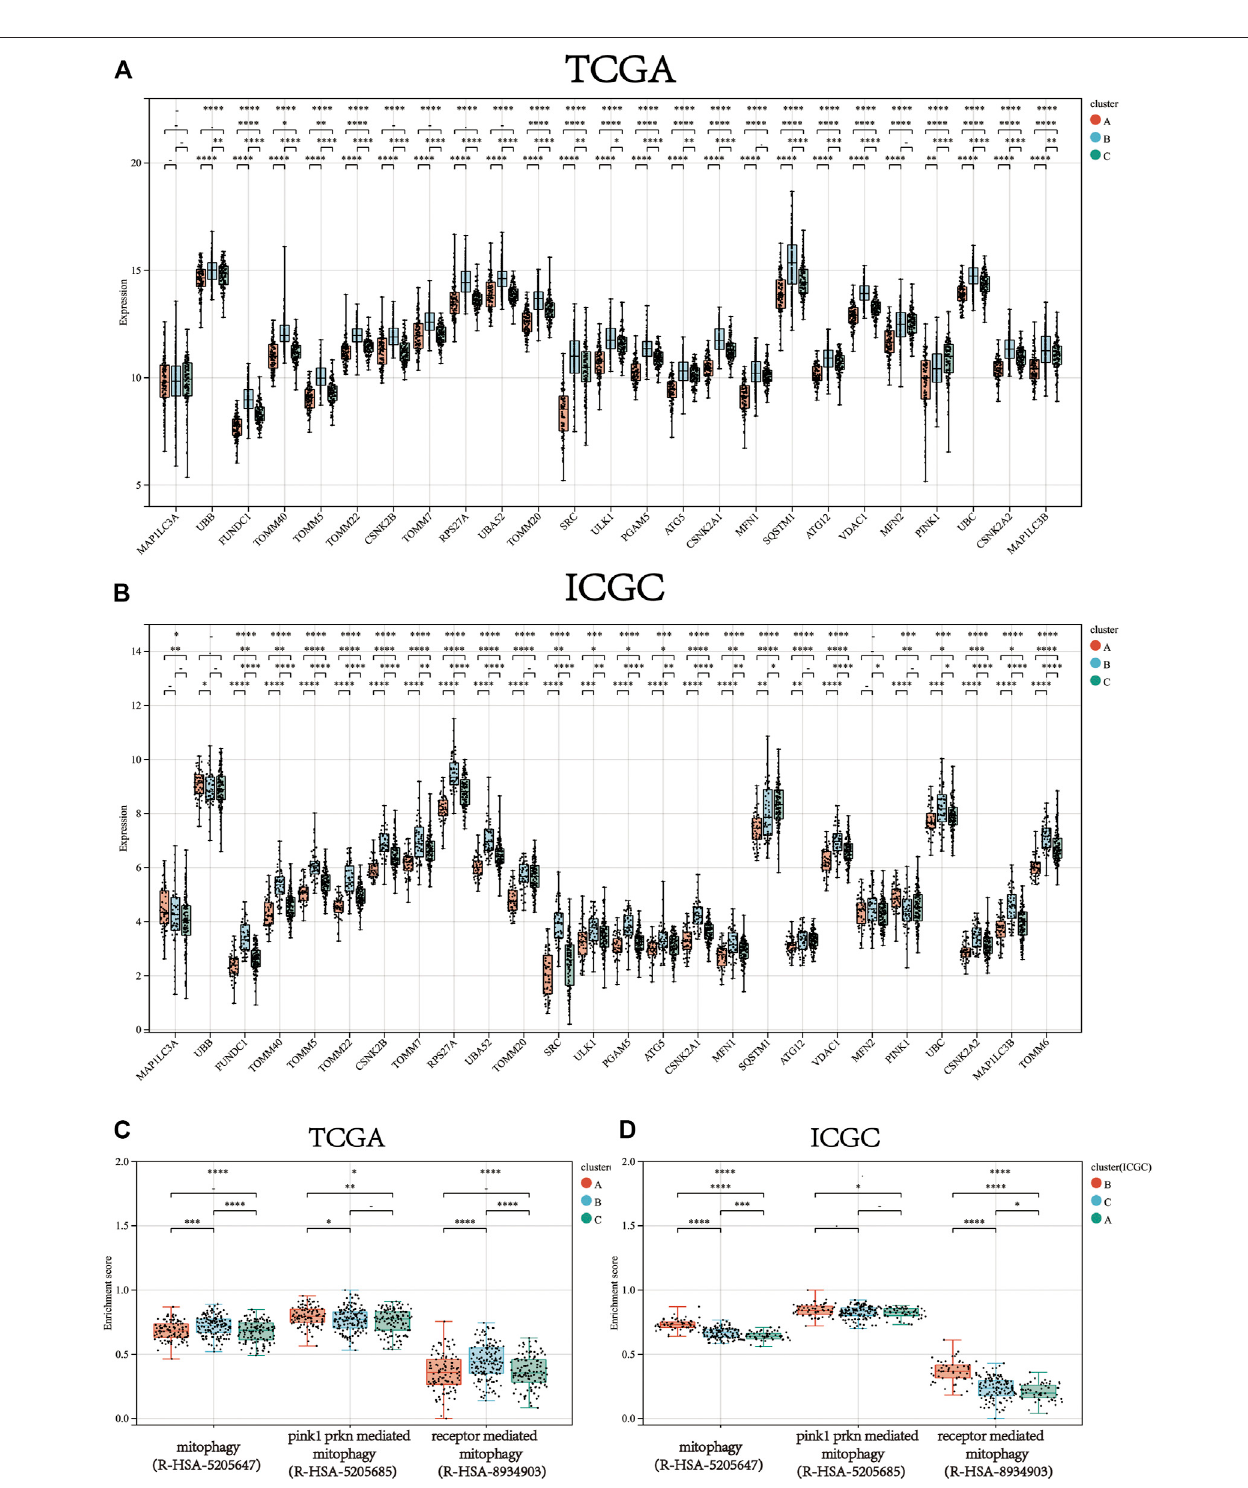
FIGURE3| ThegeneexpressionofeachmitophagyregulatorsbetweenthedifferentmitophagysubtypesinTCGALIHC (A) andICGCLIRI-JP (B) .Theenrichment score ofthree mitophagy-relayedgene sets between thedifferentmitophagy subtypes in TCGA LIHC (C) and ICGC LIRI-JP (D) . Theupper and lowerends ofthe boxes represented interquartile range of values. The lines in the boxes represented median value, and black dots showed outliers. The asterisks represented the statistical p value (* p < 0.05; ** p < 0.01; *** p < 0.001; **** p < 0.0001).